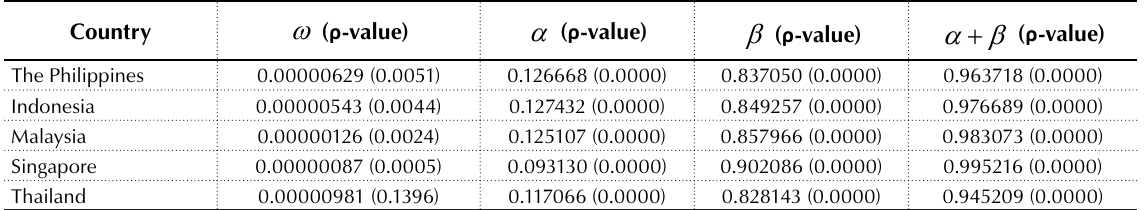
Table 4. Return series estimation results using GARCH